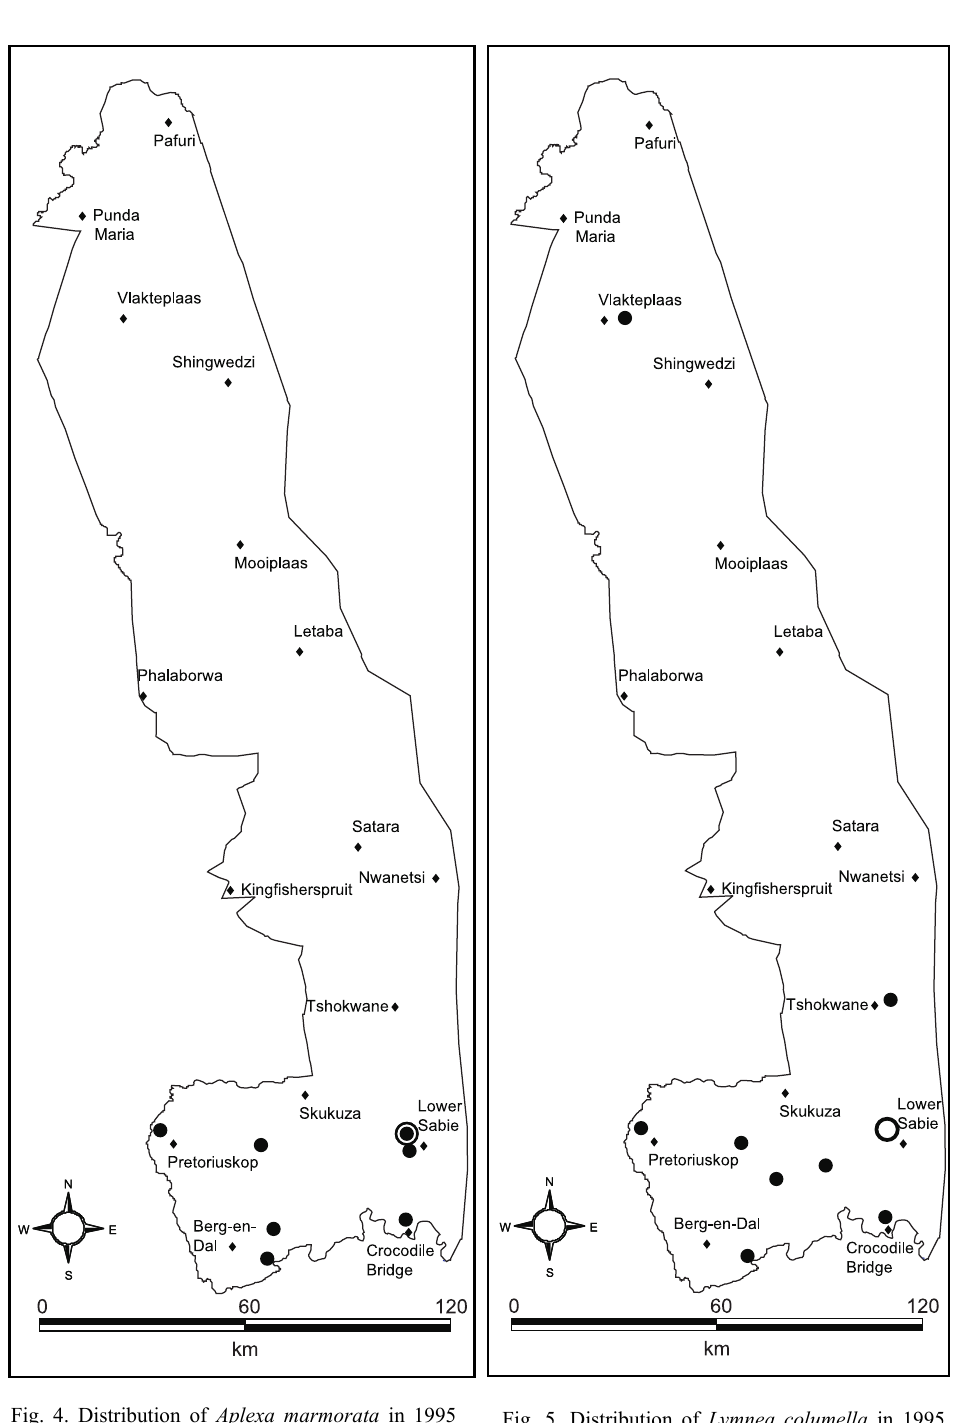
Fig. 5. Distribution of Lymnea columella in 1995 (O) and 2001 ( • ). Rainfall monitoring stations ( ♦